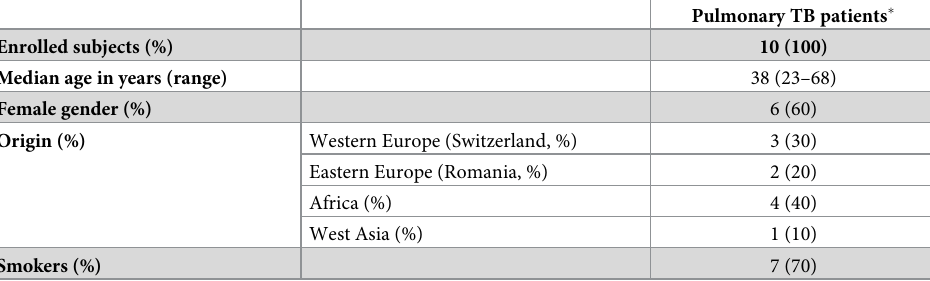
Table 3. Demographic characteristics of the subjects enrolled at the Centre Hospitalier Universitaire Vaudois (CHUV) in Lausanne, Switzerland.